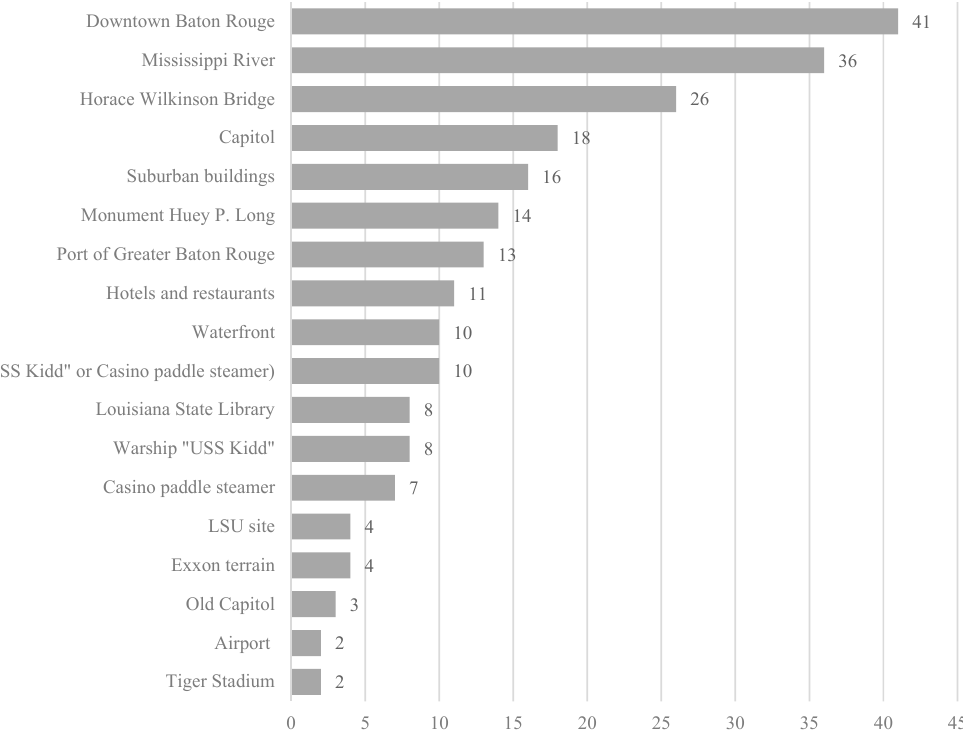
Figure 10. The thematic foci of the 100 Baton Rouge images examined (own survey and representation).